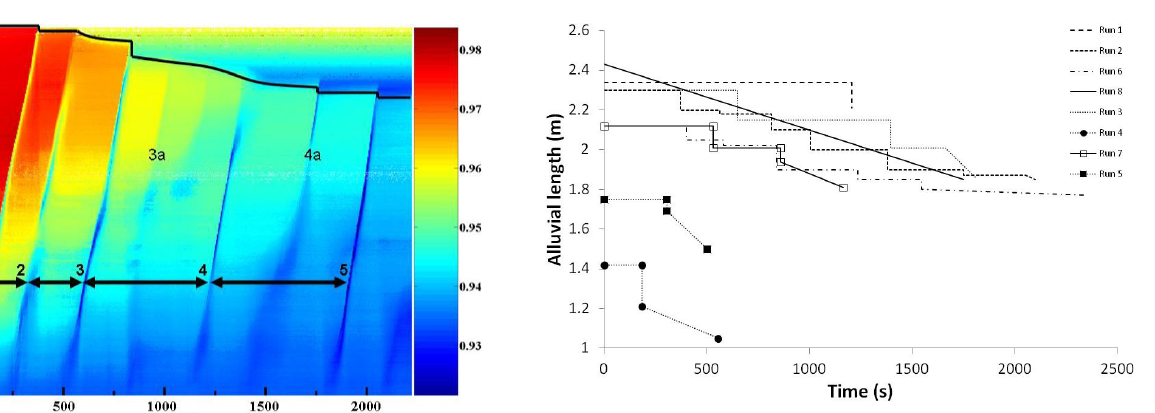
Figure 4. Plots of the time variation of alluvial length for each experiment. 437